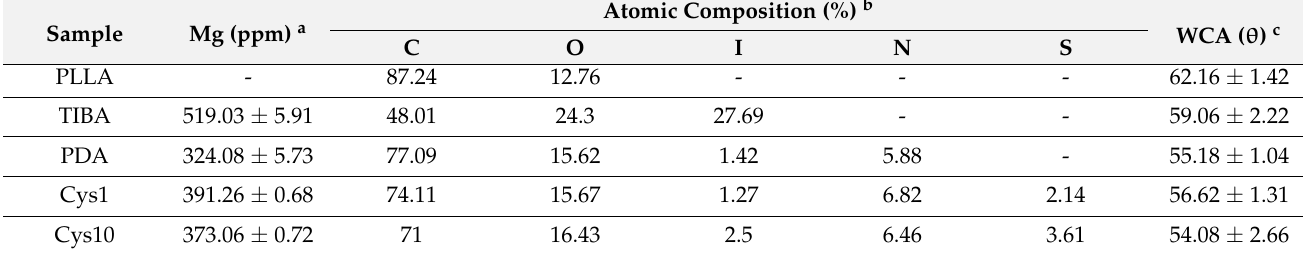
Table 1. Surface characterization of the coated PLLA films.